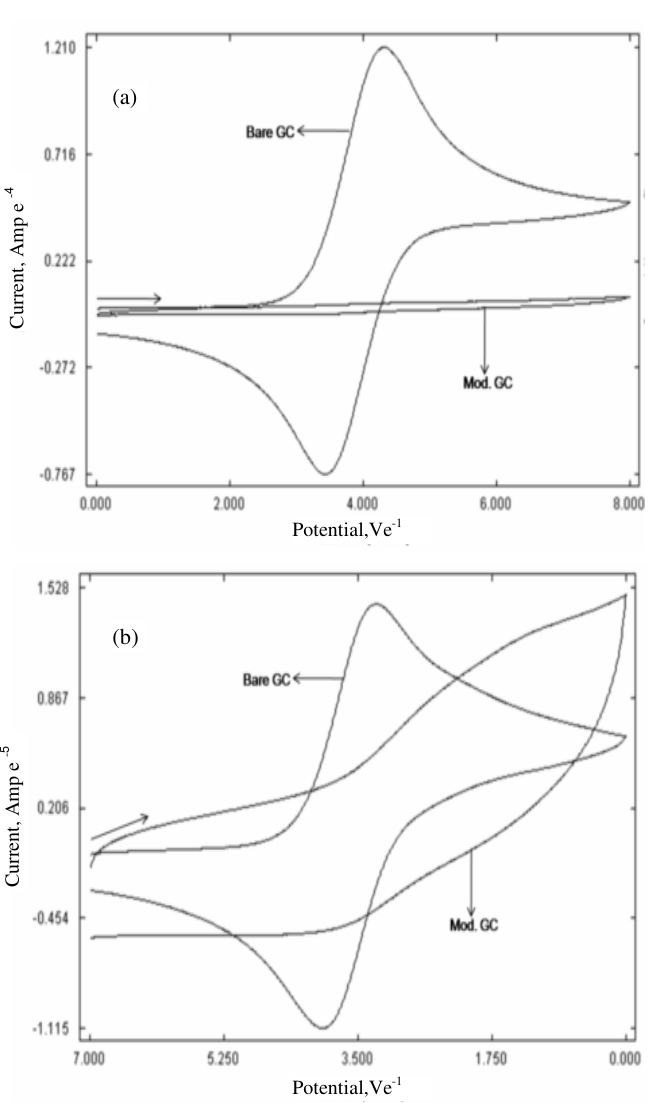
Figure 7 . Overlaying surface voltammograms for second peak a) the bare GC and HIBD modified GC with ferrocene and than b) the bare GC and HIBD modified GC with